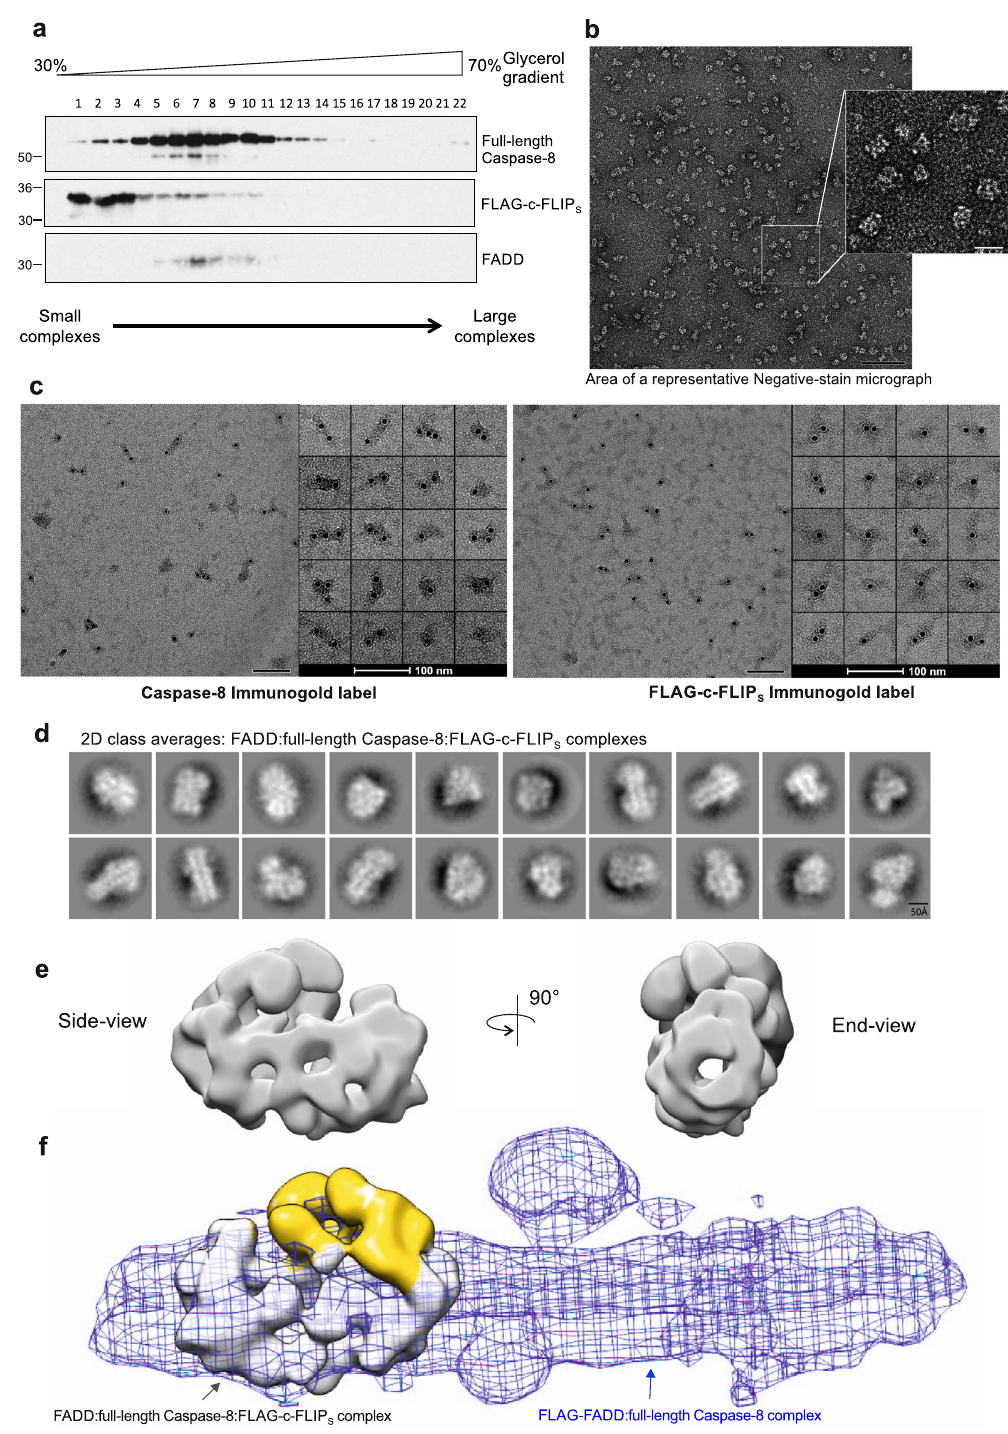
Fig. 5 c-FLIP short (c-FLIP S ) prevents Caspase-8 fi lament elongation altering the architecture of the complex. a Western blot of Glycerol Density Gradient pro fi les of FADD:full-length Caspase-8:FLAG-c-FLIP S complexes. Western blots are representative of 3 independent experiments. b Representative negative stain micrograph of FADD:full-length Caspase-8:FLAG-c-FLIP S complexes (Scale bar, 100nm; inset, 25nm). Micrographs are representative of 3 independent experiments. c Immuno-gold labeling of p18 subunit of Caspase-8 and FLAG-tag on puri fi ed FADD:full-length Caspase-8:FLAG-c-FLIP S complexes (Fraction 6), visualized by EM. Micrographs are representative of 3 independent experiments. d Reference-free 2D class averages generated in CryoSPARC of negative-stain EM of FADD:full-length Caspase-8:FLAG-c-FLIP S complexes. e Different orientations of low-resolution EM volume of FADD:full-length Caspase-8: FLAG-c-FLIP S complexes; side-view (left) and end-view (right). f Overlay comparison of FADD:full-length Caspase-8:FLAG-c-FLIP S complex negative-stain EM volume and FADD:full-length Caspase-8 complex EM volume; additional EM volume only present in c-FLIP S -inhibited complex is shown in yellow. Source data are provided as a Source Data fi